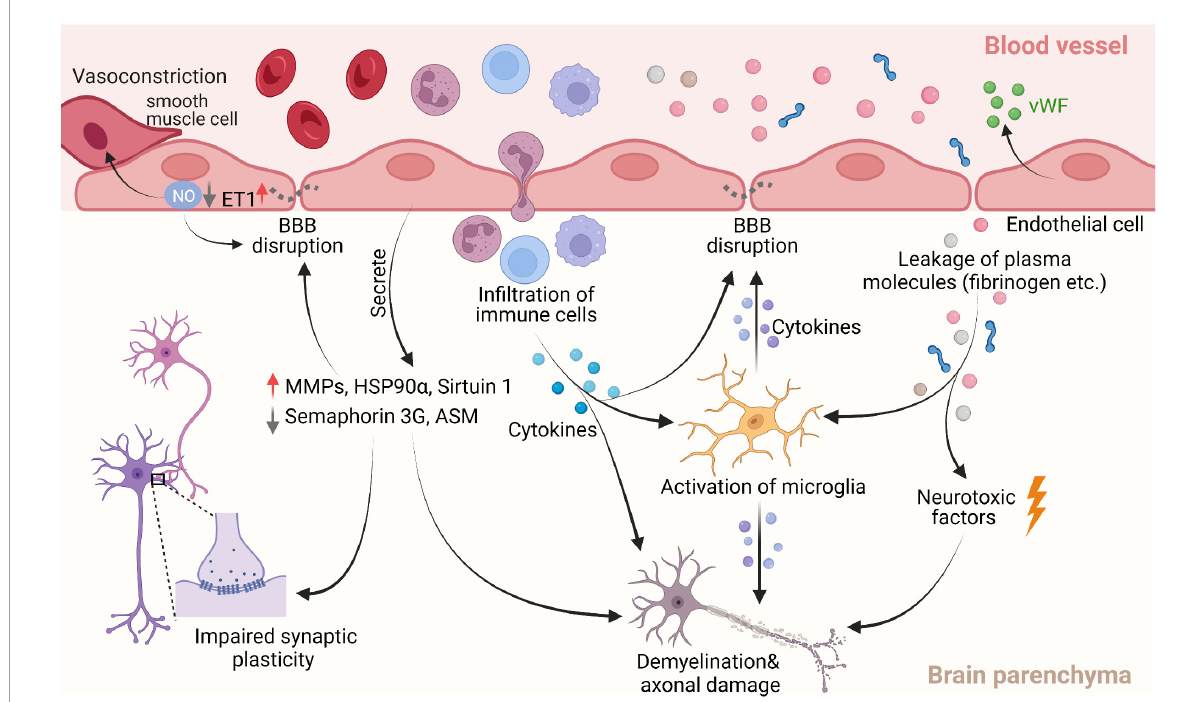
FIGURE2 Pathological characteristics of cerebral small vessel disease (CSVD). Of them, decreased nitric oxide (NO) bioavailability is the most commonly used marker of dysfunction in endothelial cells (ECs). Reducing NO levels can lead to less vasodilation of neighboring smooth muscle cells, which in turn causes nitrosylation or nitrosation of tight junction (TJ) proteins, ultimately resulting in BBB disruption. Increased ET1 release by dysfunctional ECs can give rise to pathological vasoconstriction. The reduction of semaphorin 3G and sirt1 due to endothelial dysfunction can affect synaptic plasticity and BBB integrity respectively, and consequently, contribute to cognitive decline. Additionally, the factors secreted by dysfunctional ECs such as von Willebrand factor (vWF), heat shock protein 90 α (HSP 90 α ), acid sphingomyelinase (ASM) and matrix metalloproteinases (MMPs) can induce vessel damage directly, as well as impair the integrity of the BBB and white matter. Compromising the BBB allows for entry of potential detrimental plasma components and immune cells into the brain parenchyma, further promoting BBB breakdown and white mater damage via neuroinflammation and direct neurotoxic effects. Figure created using